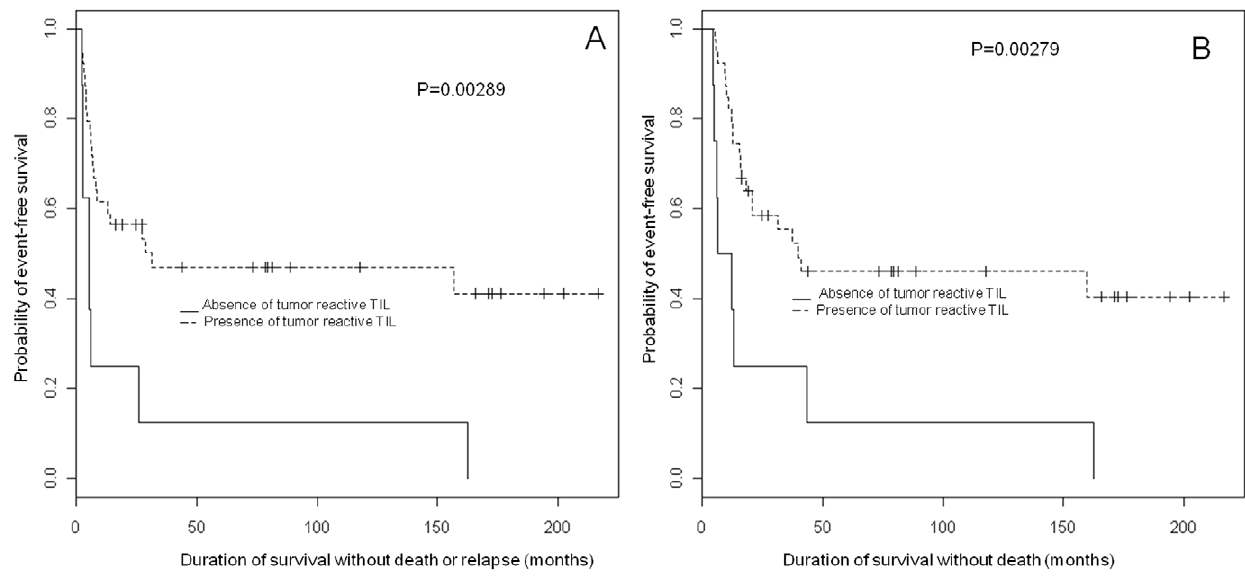
Figure 1. The presence of tumor-reactive TIL is associated to increased PFS and OS. PFS (A) and OS (B) curves for 47 patients from metastatic melanoma based on the presence of tumor-reactive TIL: cases were divided into two groups, presence of tumor-reactive TIL and absence of tumor-reactive TIL.